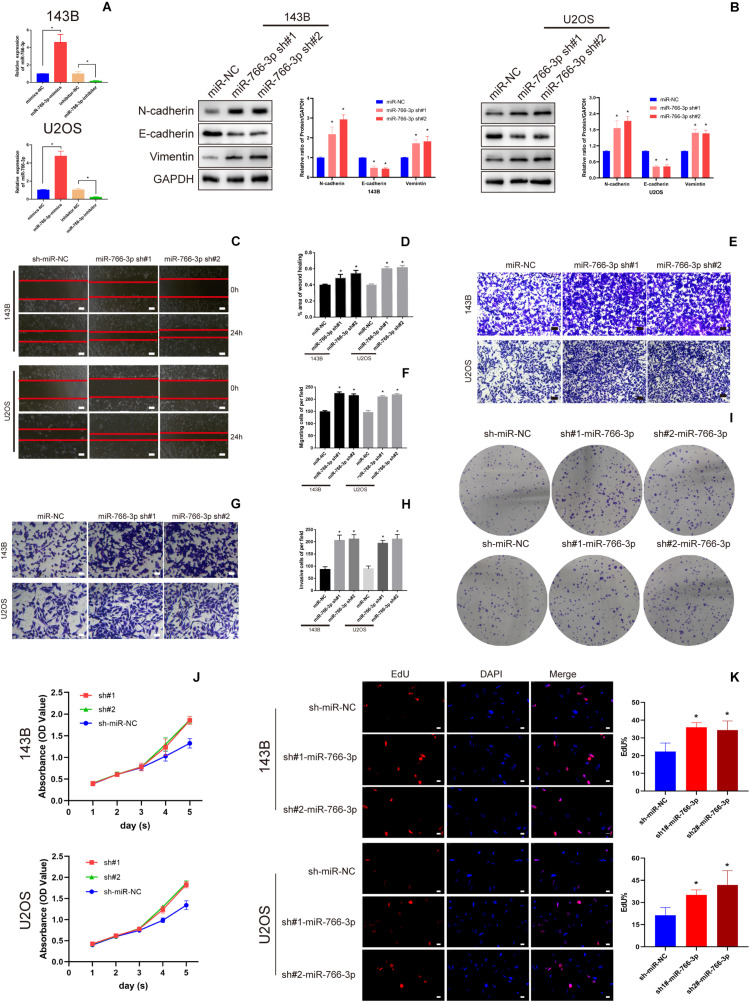
Downregulating miR-766-3p promoted OS cell EMT, migration and invasion in vitro. (A) miR-766-3p lentiviruses were successfully transfected into 143B and U2OS cell lines (n = 3). (B) miR-766-3p sh#1 and miR-766-3p sh#2 increased the expression level of metastasis-related proteins in 143B and U2OS (n = 3). (C–F) The knockdown of miR-766-3p notably promoted the invasion and migration of 143B and U2OS cells (n = 4). (G,H) The Transwell invasion assays indicated that the knockdown of miR-766-3p significantly increased the invasive ability of OS cells (n = 4). (I–K) Colony formation, CCK-8 and EdU assays demonstrated that downregulating miR-766-3p promoted the proliferation of OS cells (n = 4). Data are presented as the means ± SD. *P < 0.01.